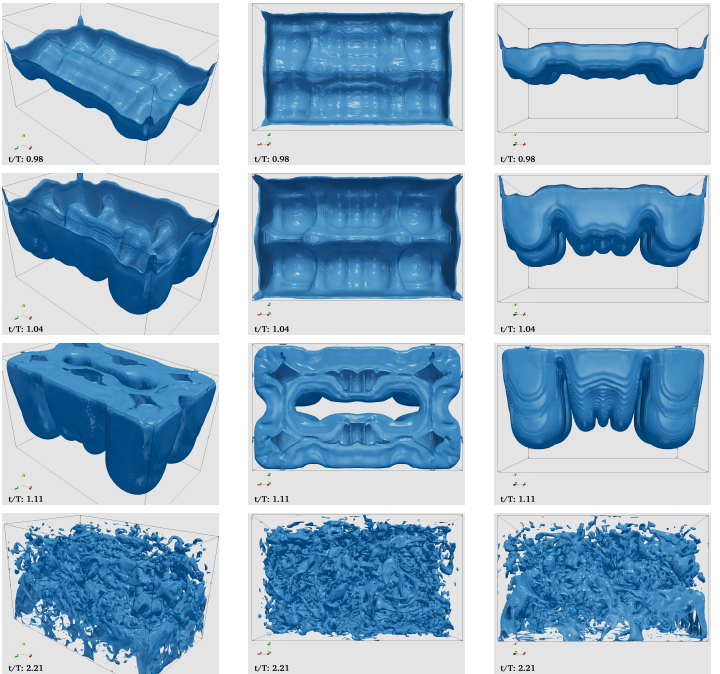
Figure 30. Three-dimensional water E LEMENTAL ® results on the N 50 resolution at various time instants prior to and shortly after the first roof impact.